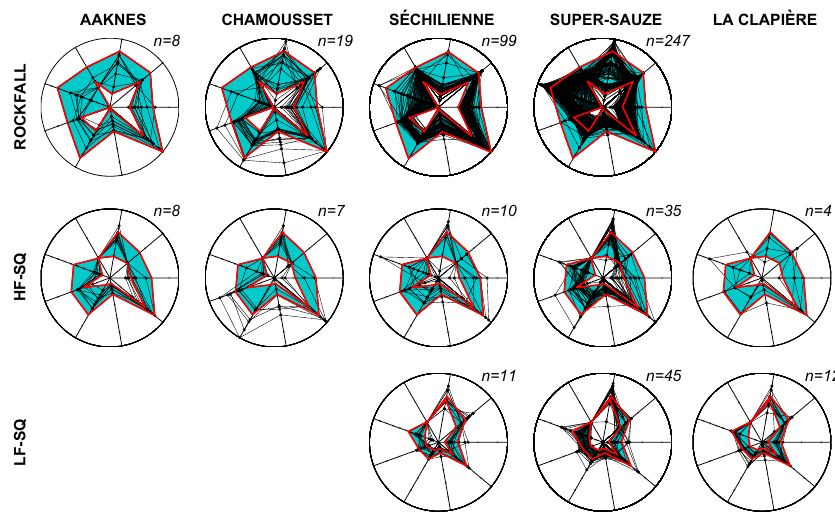
Figure 12. Variability in the signal features of classes “rockfall”, “HF-SQ” and “LF-SQ” for five different sites: Aaknes, Chamousset, Séchilienne, Super-Sauze and La Clapière. The axes of the star diagrams are the same as in Fig.